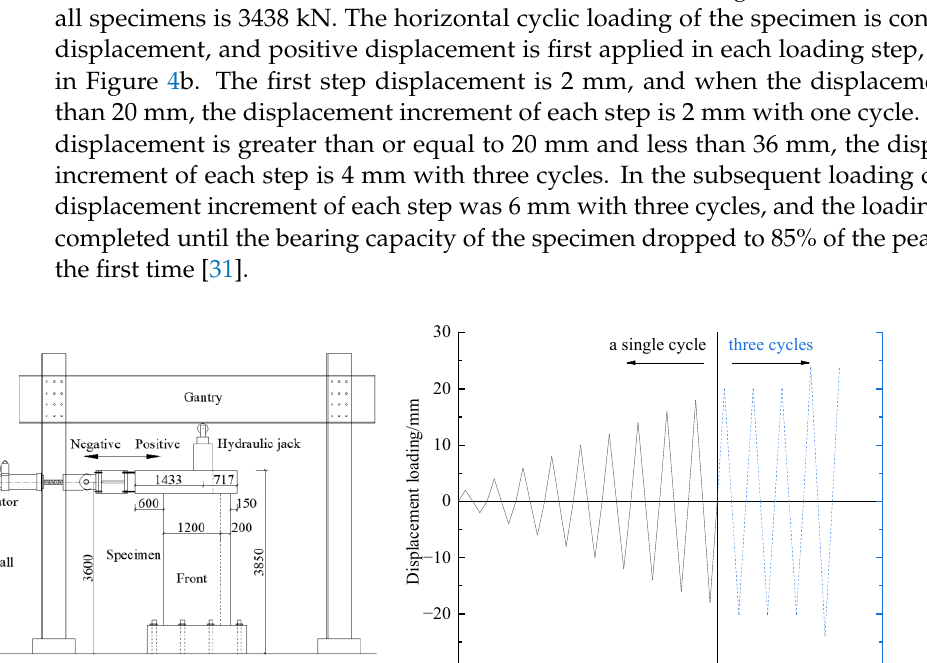
( b ) Figure 5. Dimensions of specimens and arrangement of displacement gauges: ( a ) front elevation of the specimen; and ( b ) side elevation of the specimen. 3. Results and Discussion 3.1. Failure Modes Figure 6 shows the crack distribution of LSW, LAPC-1, and LAPC-2 specimens at the ultimate displacement. It can be seen that the development pattern of cracks in each of the prefabricated walls were basically the same as that of the cast-in-place wall. The horizontal cracks first appeared at the edges of both sides of the specimens, and then gradually de- veloped obliquely towards the middle of the wall with the increase of loading displace- ment. Finally, the torsional oblique cracks with a large inclination angle appeared in the middle of the walls, and the ultimate failure pattern of the specimens was bending-shear failure.